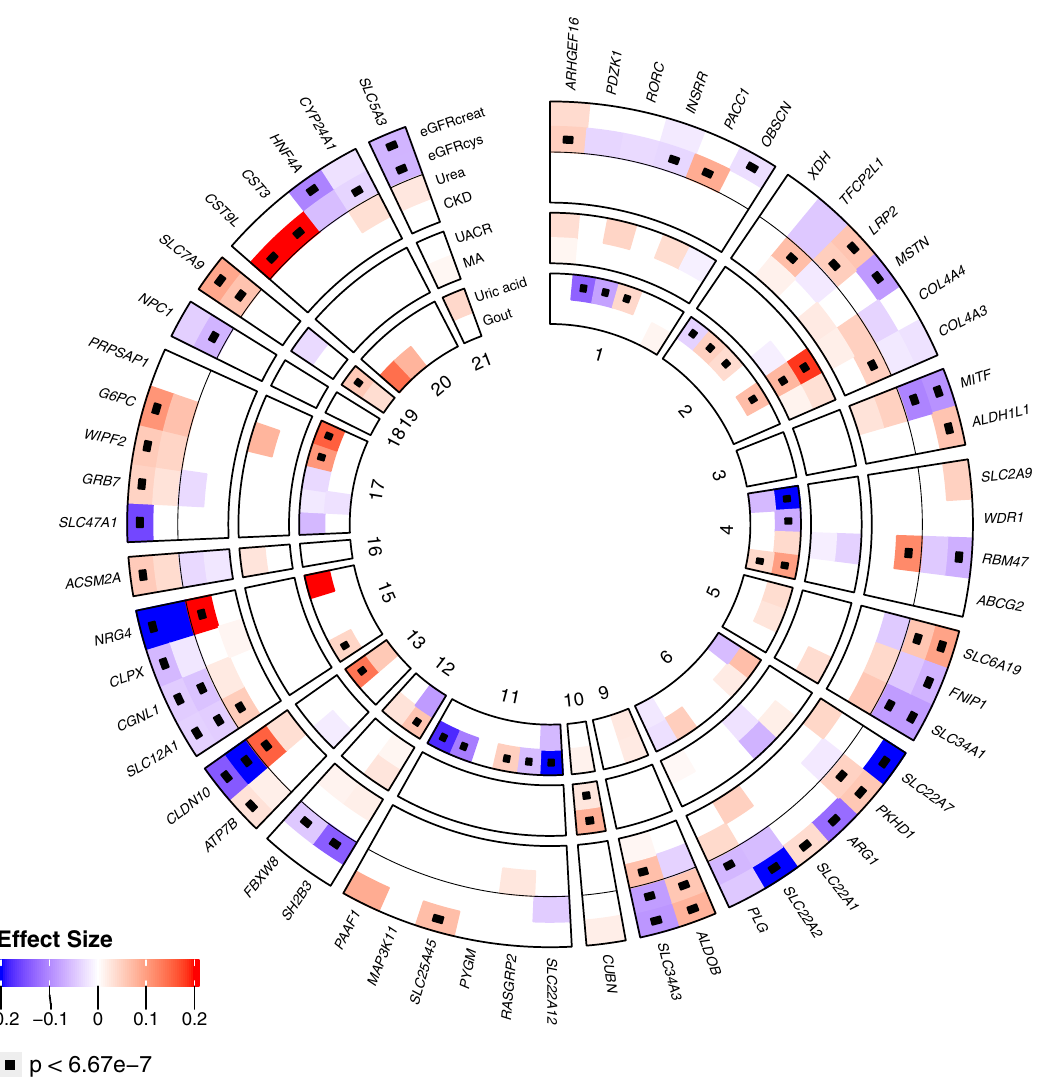
Fig. 3 | Associated genes across phenotypes. Circular heatmap for genes sig- ni fi cantly associatedwith atleast one phenotype of interest. Genes are depictedin the radials with one band per phenotype and divided by chromosome. Coloring according to effect size and direction. Signi fi cant gene-phenotype pairs